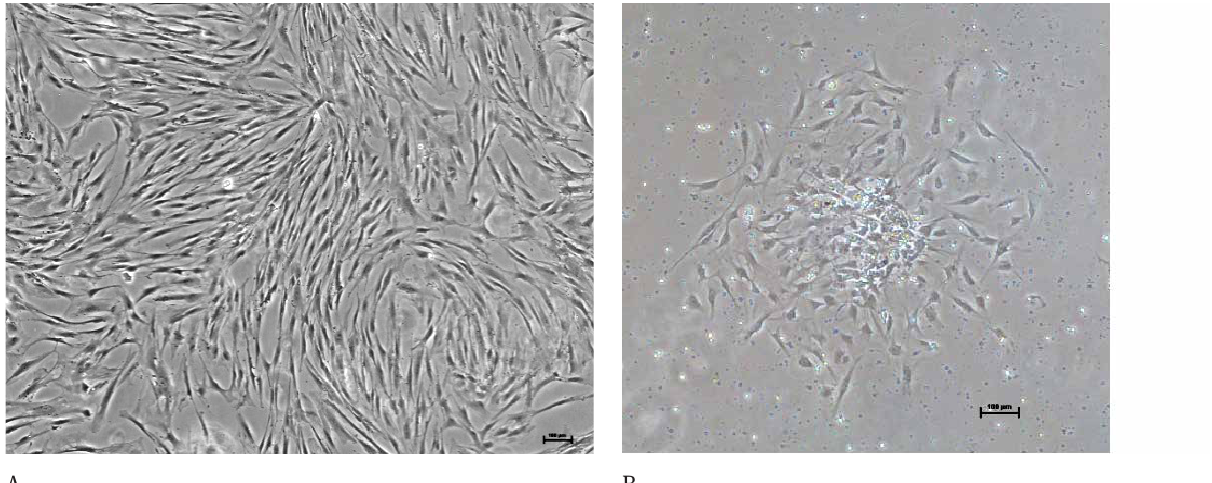
Figure 2: A–Typical spindle shape morphology of human BM-MSCs. B–Human bone marrow MSCs forming a colony 1 day after isolation by RBC lysis. Magnitute 400x, scale 100